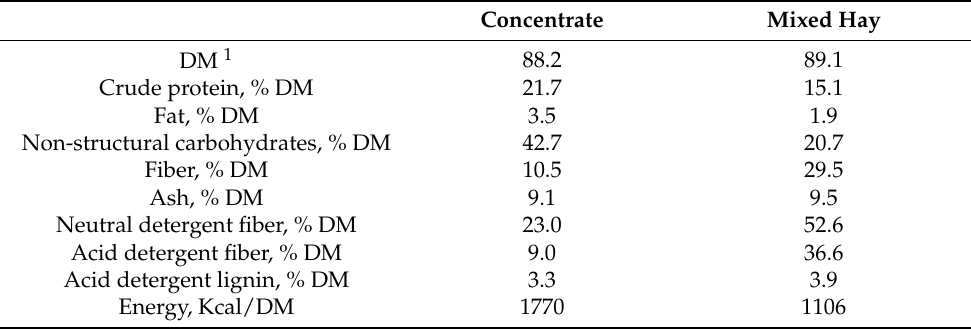
Table 1. Chemical and nutritional composition of concentrate and mixed hay utilized throughout the study. Concentrate Mixed